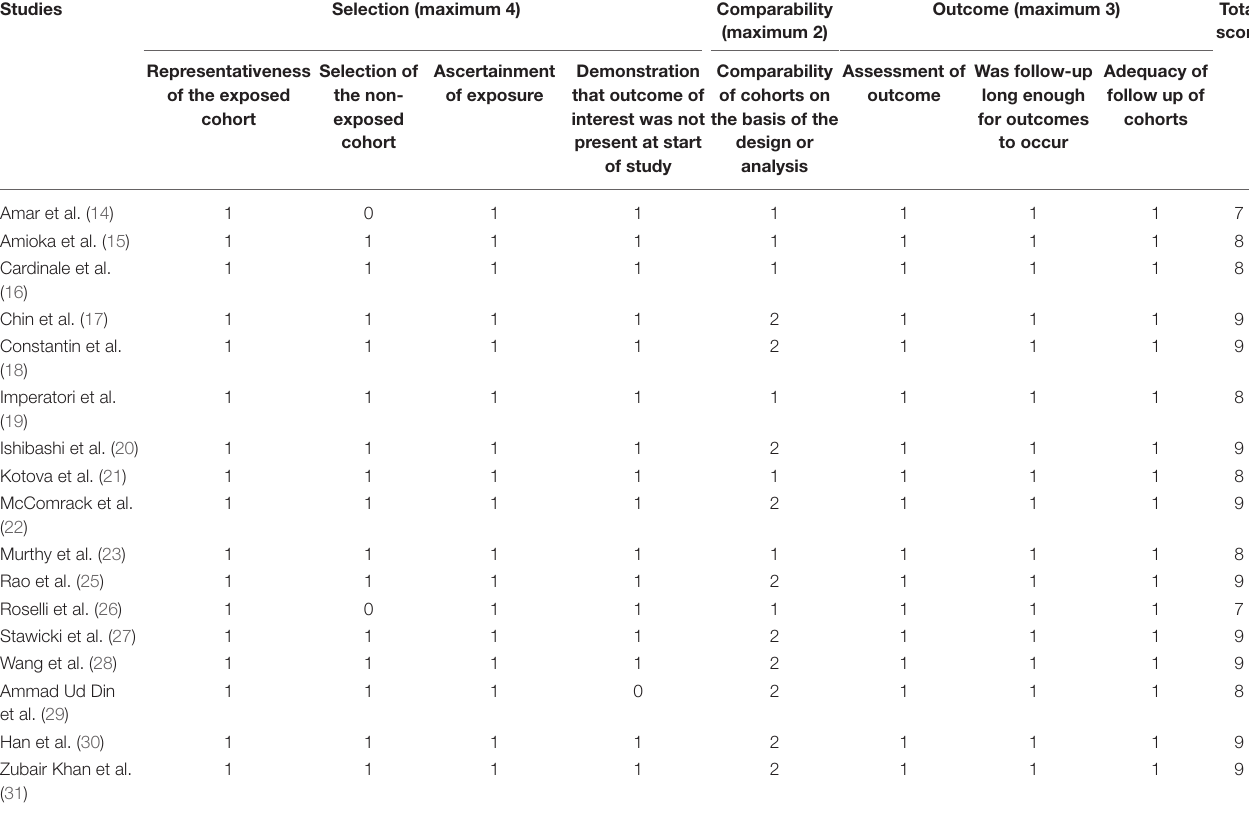
TABLE 2 | Quality assessment of cohorts using New Ottawa scale (NOS).